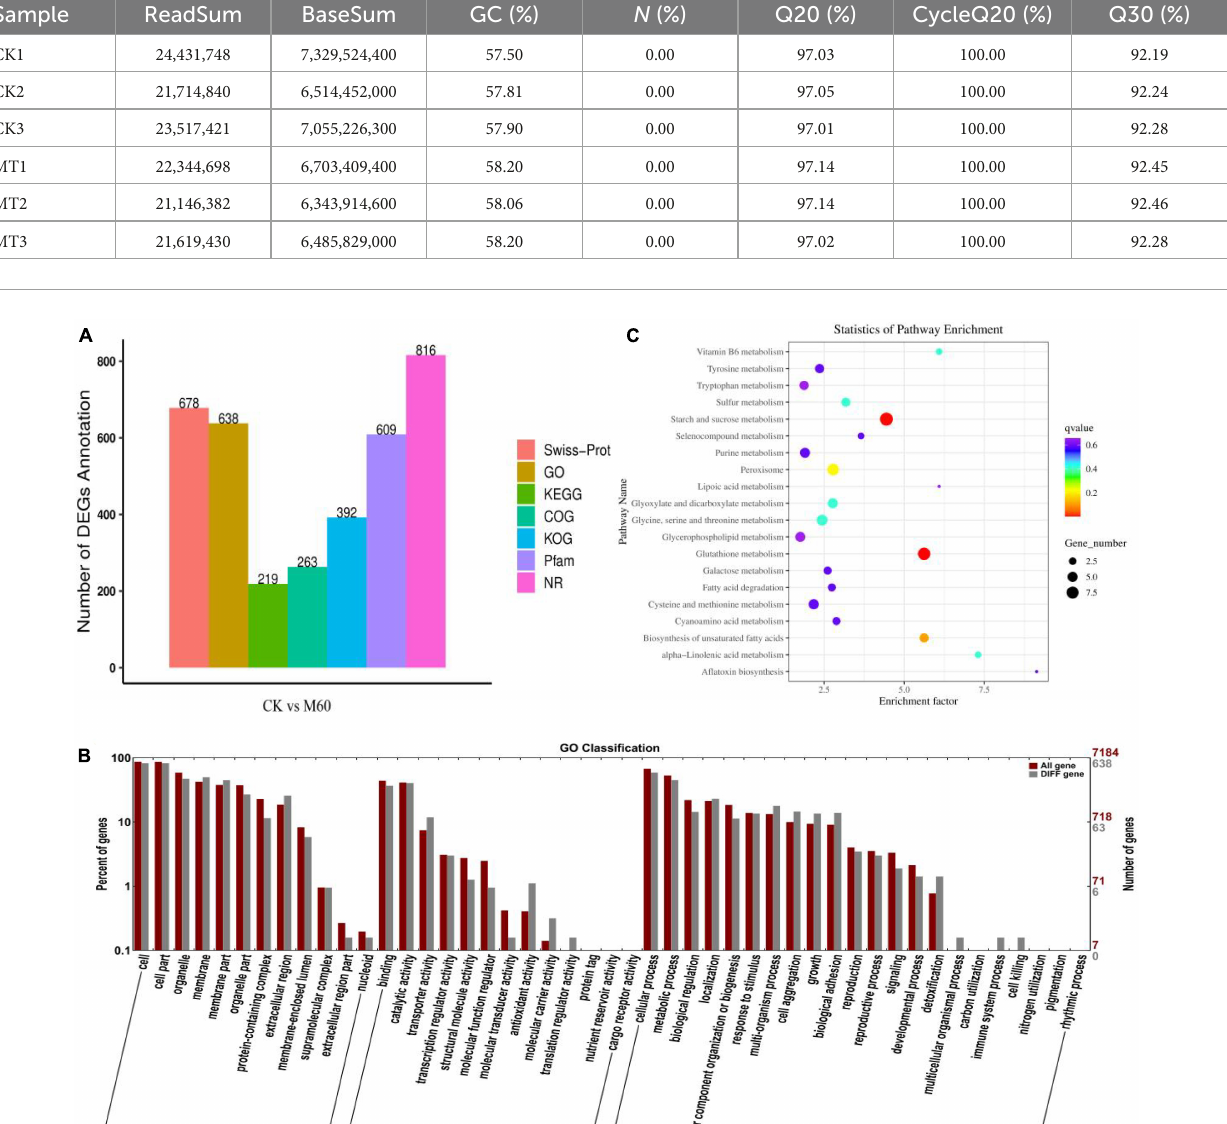
TABLE 3 Transcriptome sequencing data of C. militaris under control and MT treatment. Sample